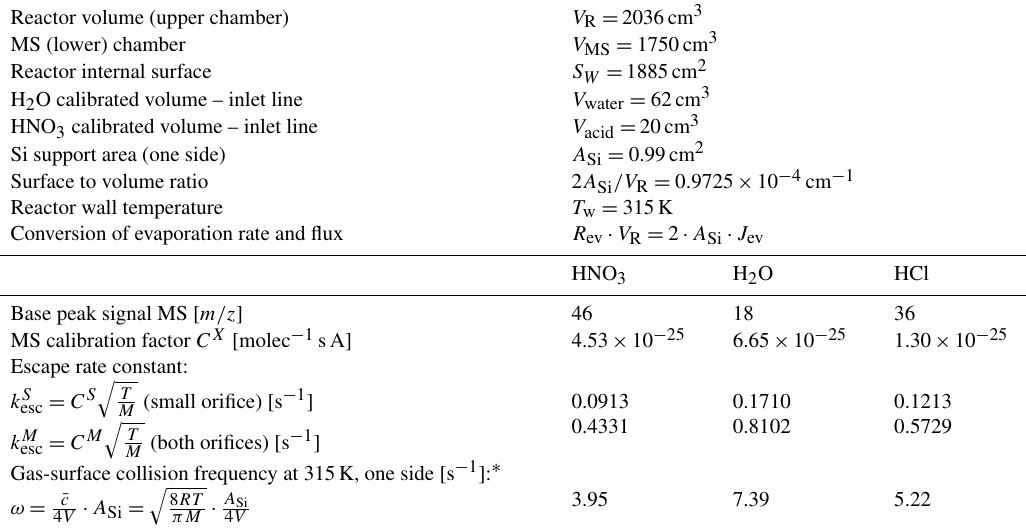
Table 1. Characteristic parameters of the stirred-flow reactor (SFR) used. Reactor volume (upper chamber) V R = 2036cm